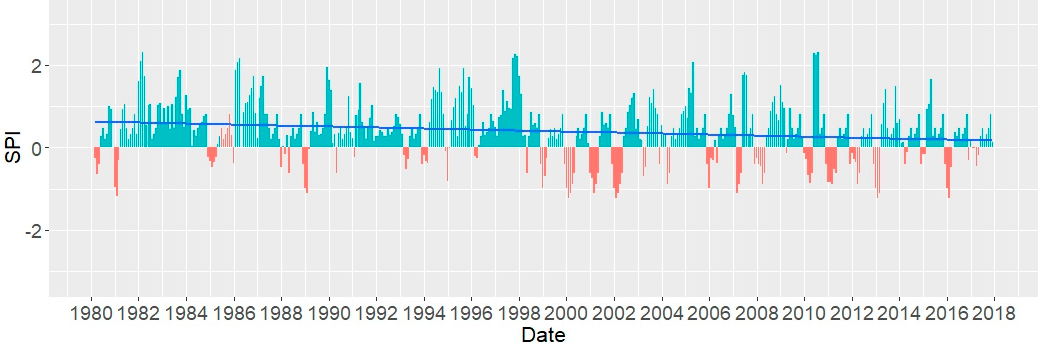
Figure 2. Three-month SPI of Jiwani station.